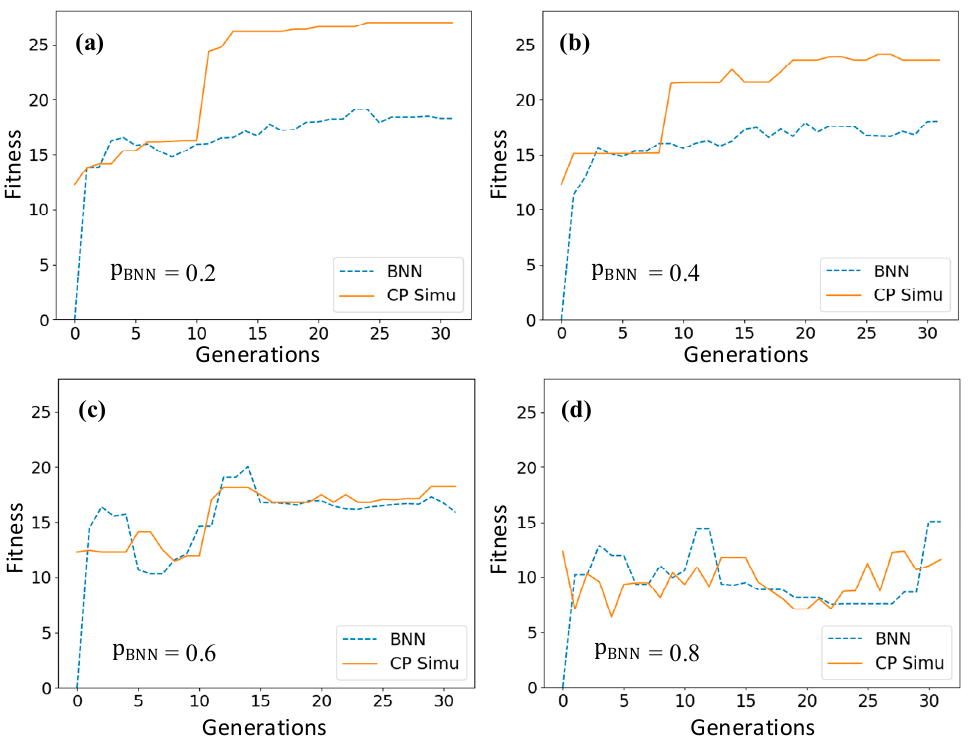
Figure 8. The best fitness in each generation calculated by phenomenological CP simulation and BNN when p BNN equals ( a ) 0.2, ( b ) 0.4, ( c ) 0.6, and ( d ) 0.8.